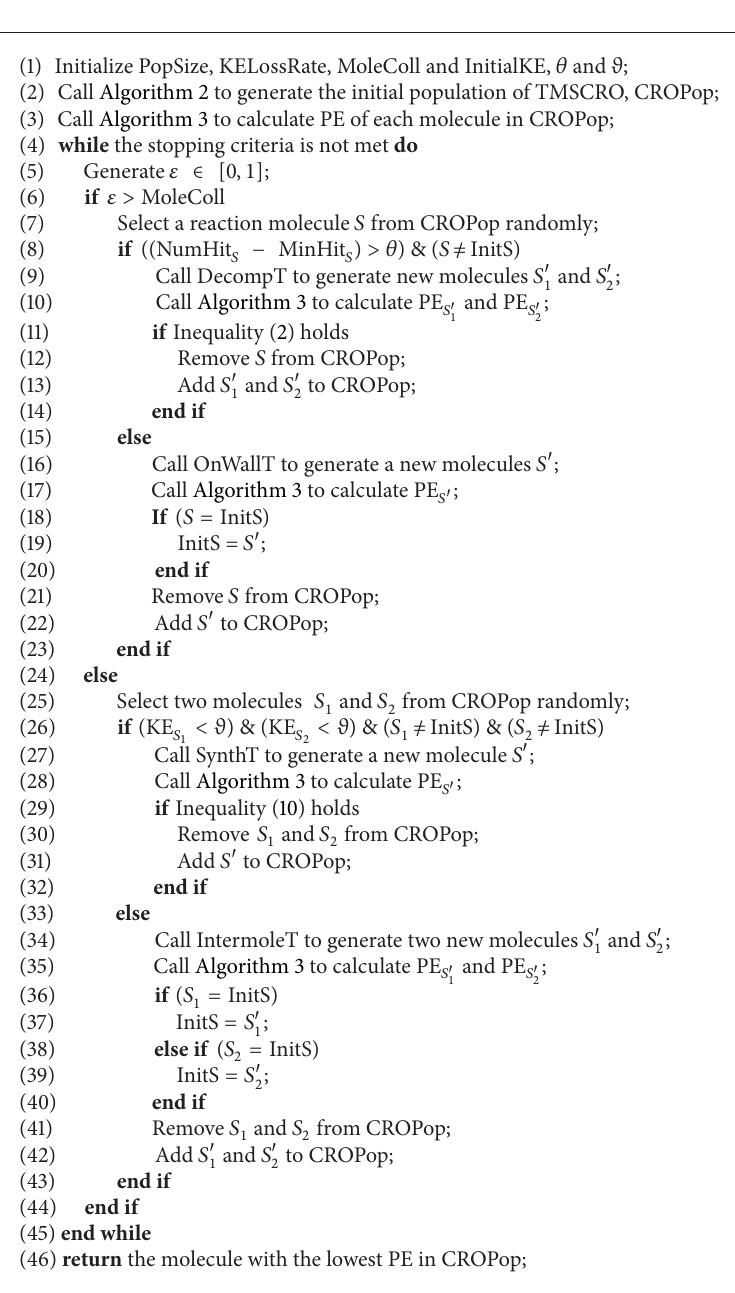
Algorithm 6: TMSCRO(DAG) The TMSCRO